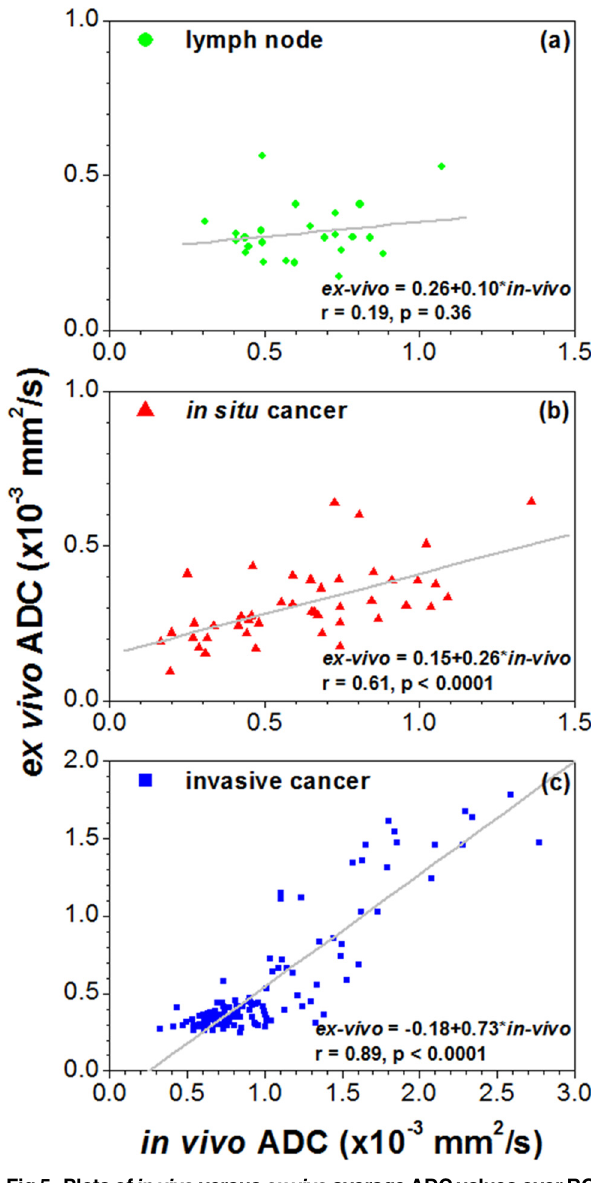
Fig 5. Plots of in vivo versus ex vivo average ADC values over ROIs for all 15 mice. (a) lymph nodes, (b) in situ cancers, and (c) invasive cancers. The gray line is the linear fit through the points. The linear relationship between invivo and ex vivo of ADC, the correlation coefficient (r) and p value are given on the